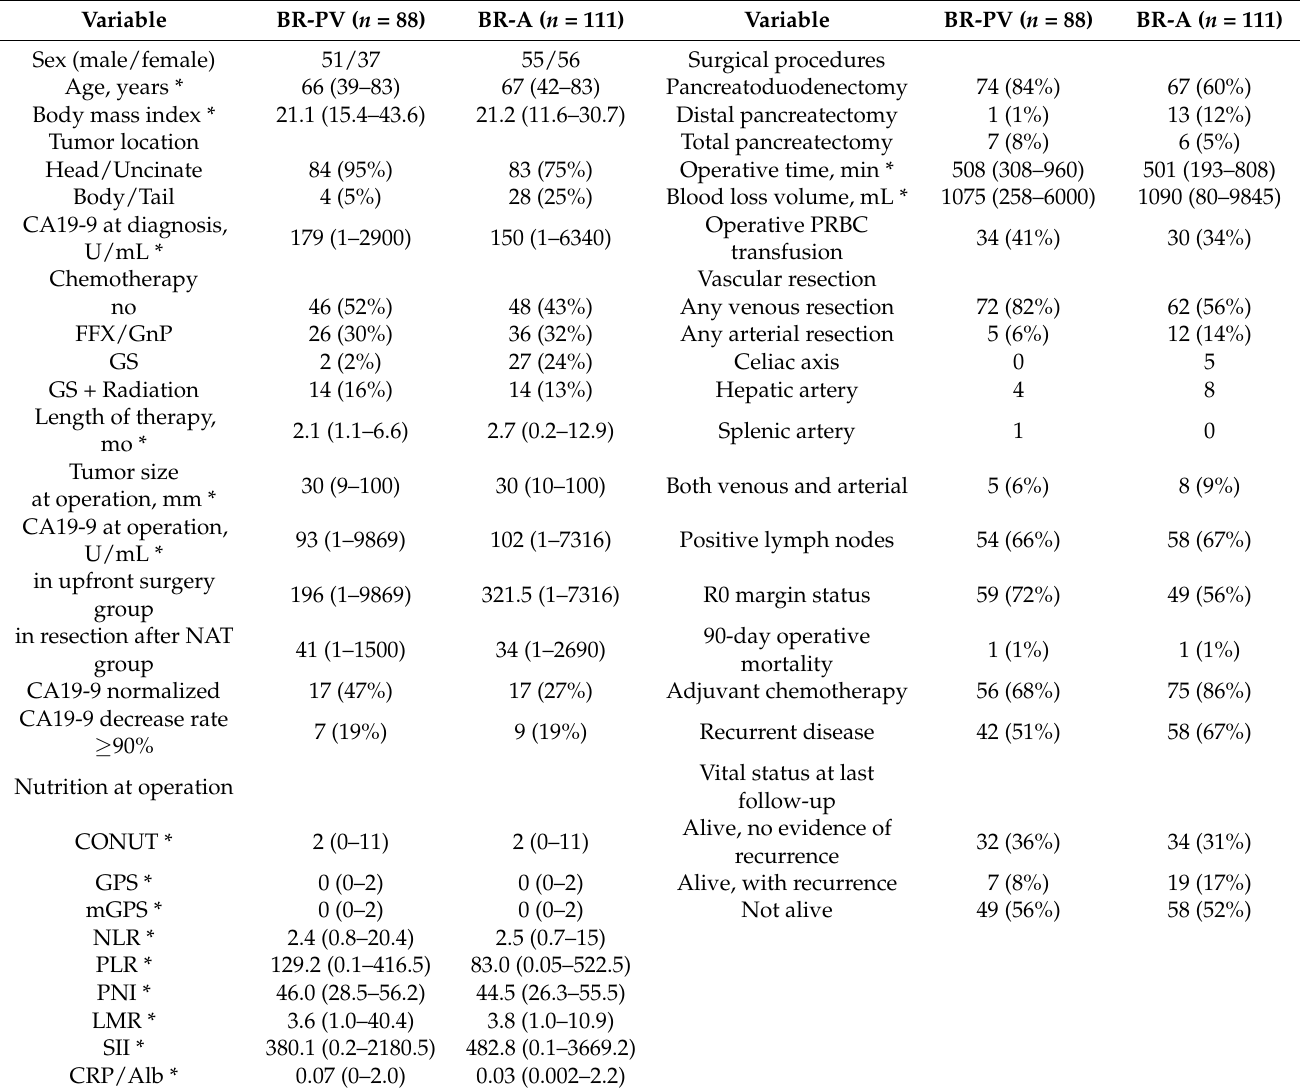
Table 1. Baseline characteristics of patients with BR-PV and BR-A.